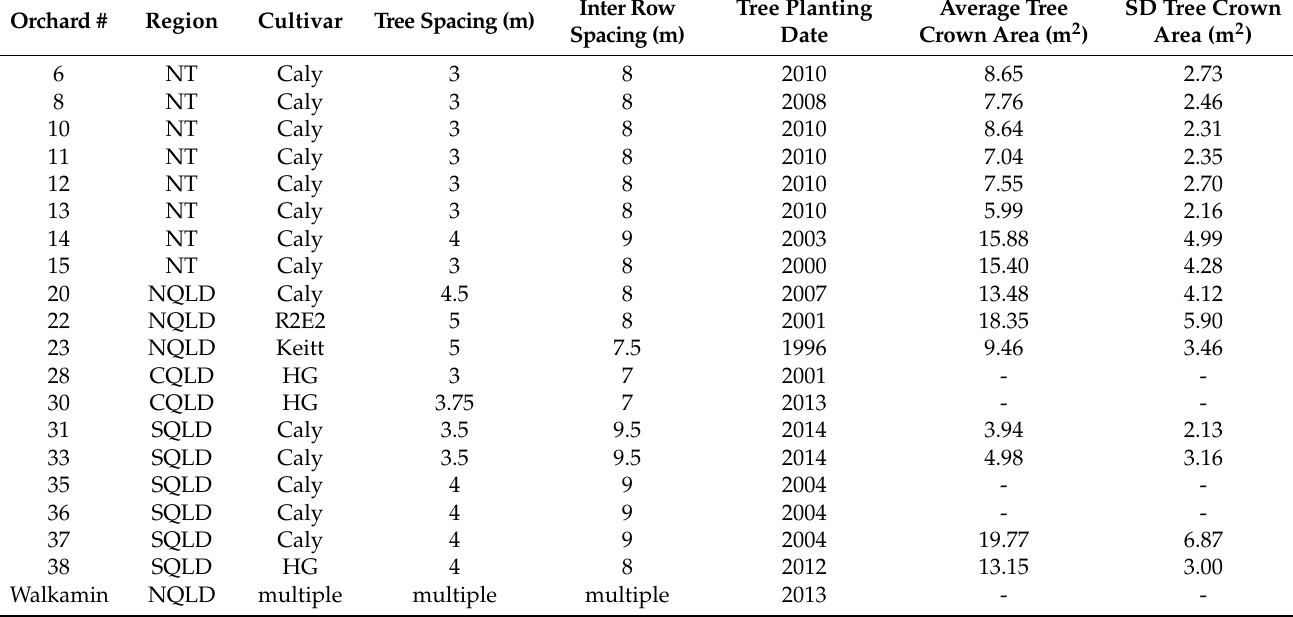
Table A2. 2019–2020 orchard characteristics. Cultivar abbreviations are Caly for Calypso ® , HG for Honey Gold and region abbreviations are NT for Northern Territory, NQLD for north Queensland, CQLD for central Queensland and SQLD for south Queensland. ‘-‘ represents data not available. Orchard numbering is tied to other tables and is an extension of that used in